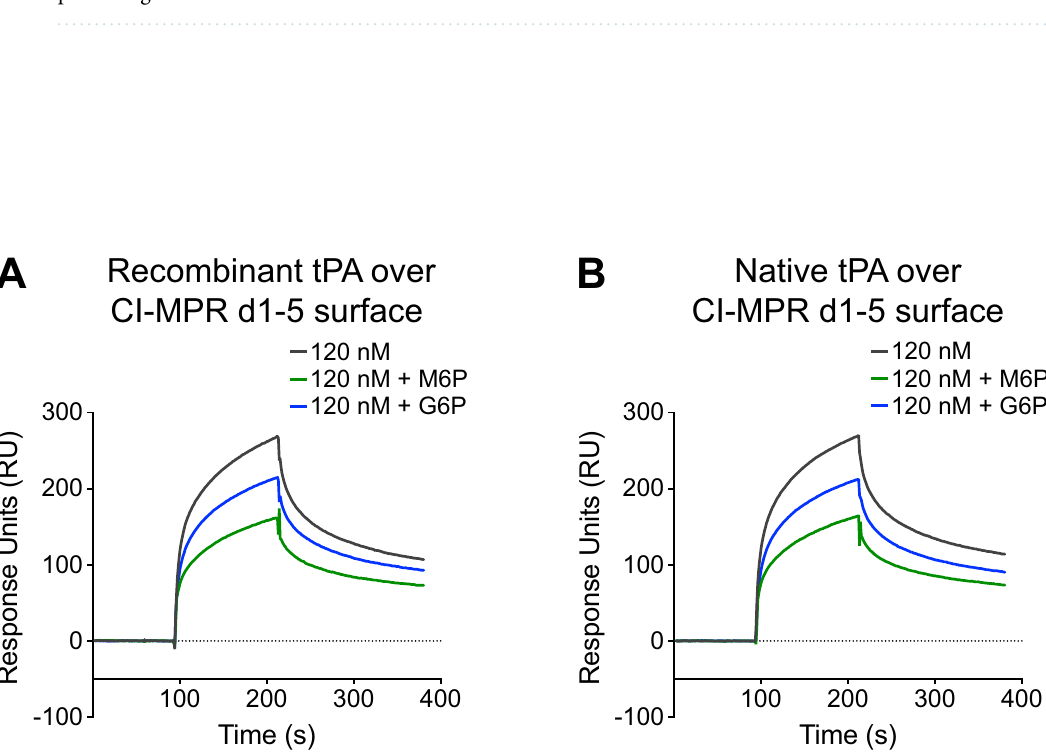
Figure 4. Recombinant and native tPA bind to the N-terminal third of CI-MPR with similar kinetics. Human CI-MPR d1-5 (containing a C-terminal biotin) was immobilized to a streptavidin sensor chip. ( A ) Recombinant tPA was injected at various concentrations. ( B ) For each sensorgram in ( A ), the response at equilibrium is plotted with respect to recombinant tPA concentration. The data are fit using a one site specific binding model. K d and B max are reported above the curve (best fit value ± SEM). ( C , D ) Same as in ( A and B , respectively), but with native tPA. CI-MPR d1-5 cation-independent mannose 6-phosphate receptor domains 1–5, tPA tissue plasminogen activator.